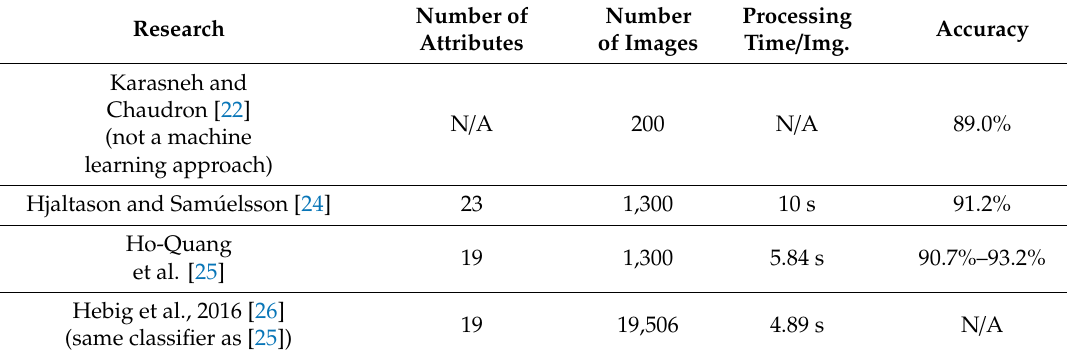
Table 1. Comparison of the examined methods to classify images as Unified Modeling Language (UML) static diagrams: number of image attributes used in the classification, number of images used to train / validate the classifier, average time required to process each image, and accuracy (percentage of agreement with the manual